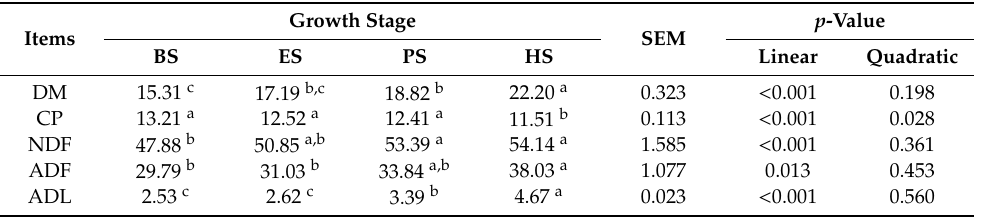
Table 1. Chemical composition of amaranth silage. (%, DM